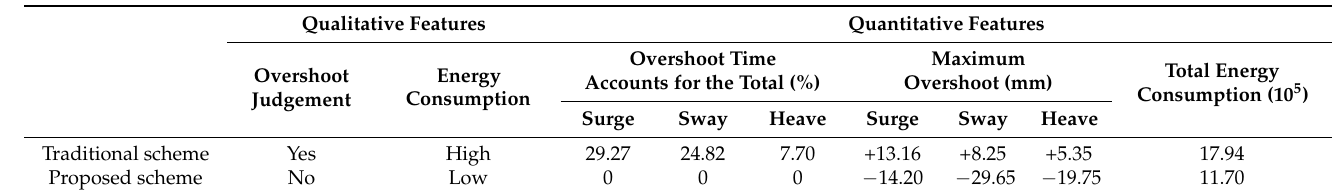
Table 7. Compare the qualitative and quantitative features of the proposed scheme and the traditional